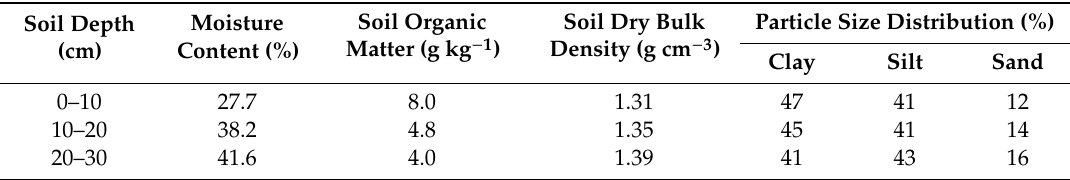
Table 1. Characteristics of the soil of the studied